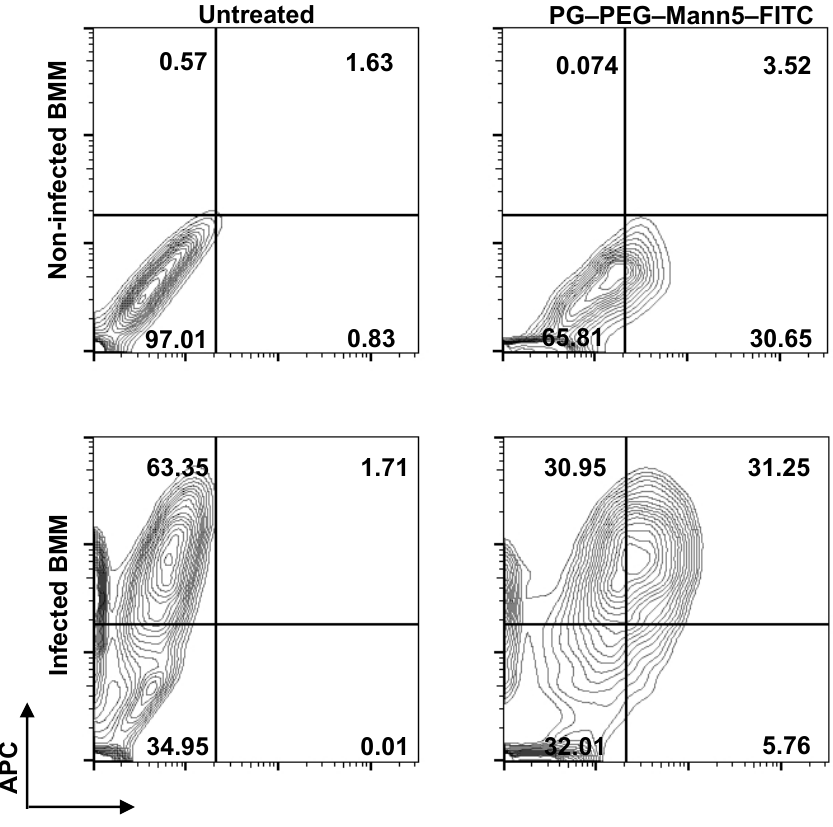
Figure 6. Quantification iRFP- L. infantum intracellular amastigotes (FL7) and PG–PEG–Mann5–FITC (FL3) colocalization. Bone marrow derived macrophages were infected with iRFP- L. infantum amastigotes. Then, uninfected and infected cultures were treated or non-treated with PG– PEGMann5–FITC nanoparticle. ( top ) Non infected bone marrow derived macrophages; (bottom) iRFP- L. infantum -infected bone marrow derived macrophages; ( right ) cultures untreated; ( left )